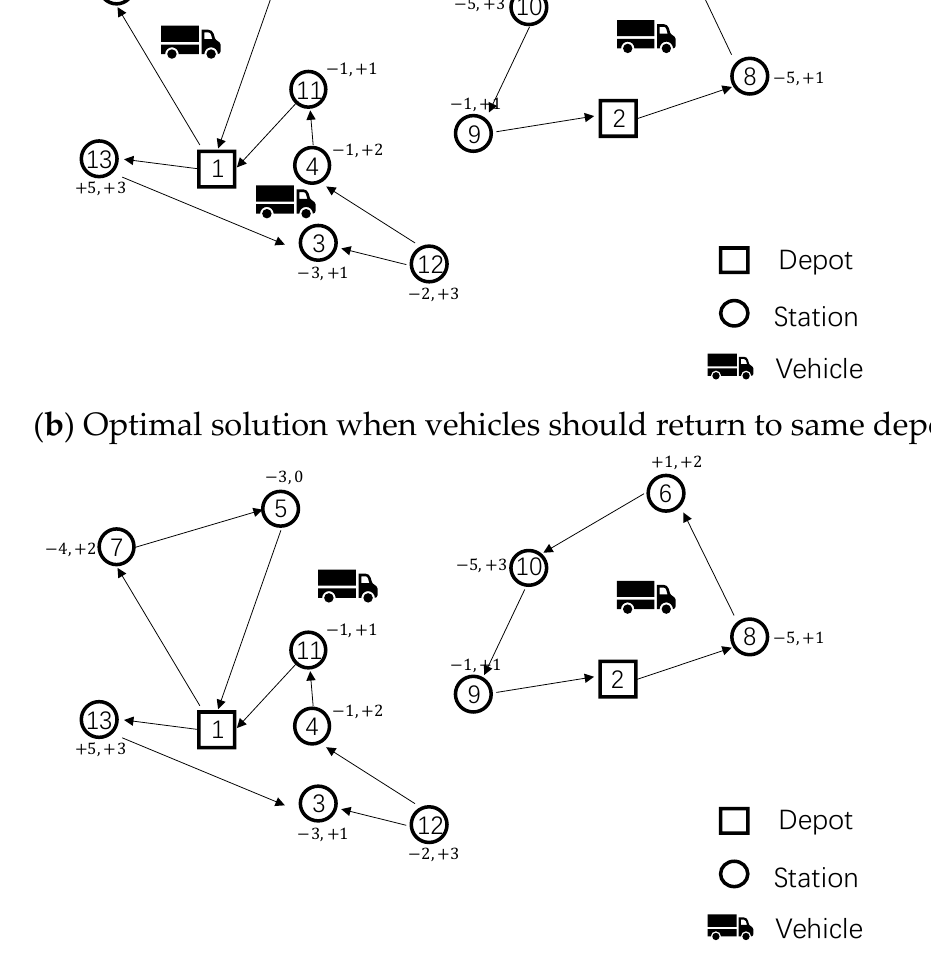
Figure 2. Optimal solution to the MSBRCP instance (#3 of benchmark instances). A square represents a depot, a circle represents a station. Numbers beside each circle represent the rebalancing demand and collection request of the station indicated inside the circle.